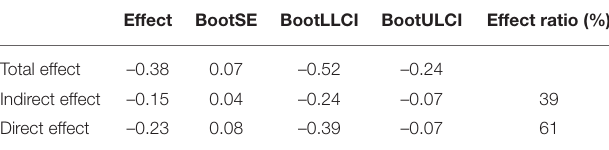
TABLE 4 | Mediation Effect of APS-R Disc, SPSI-R NPO and SWB ( N =